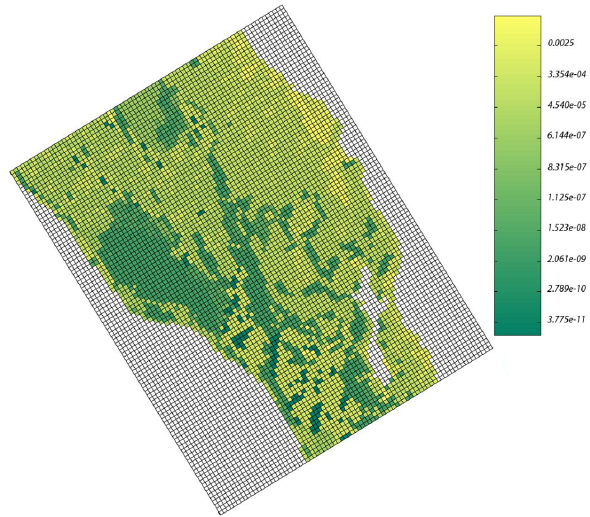
Figure 4: Map of meteoric recharge Fig. 4. Map of meteoric recharge.